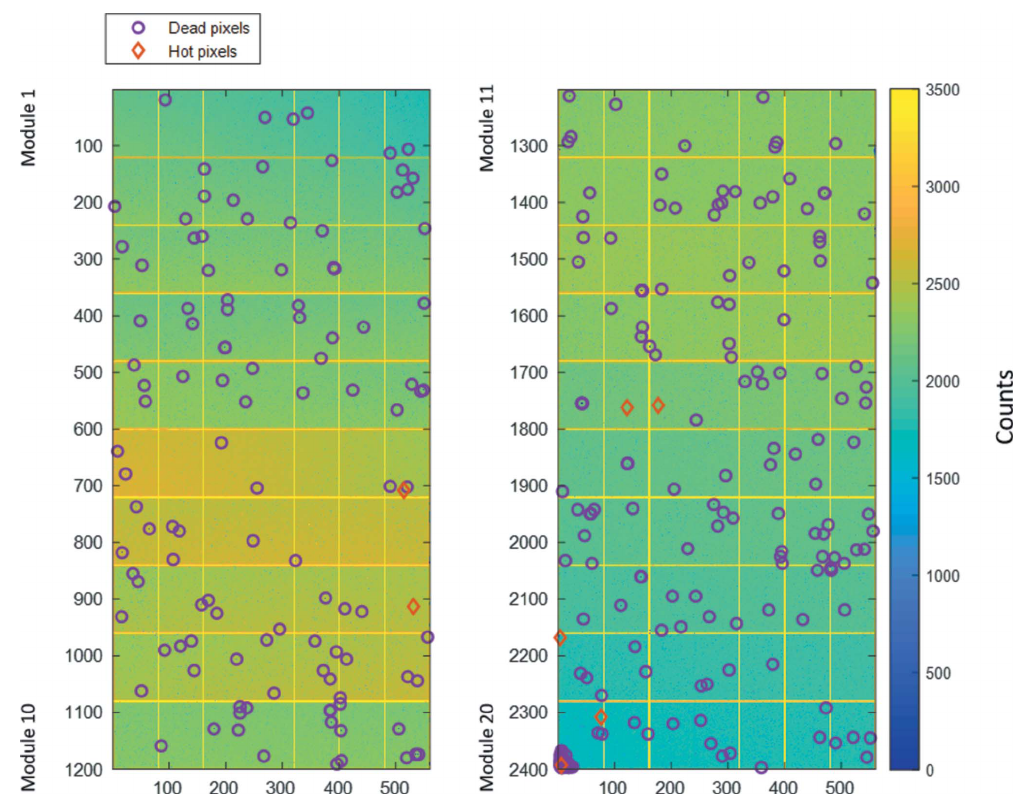
Figure 8 CirPAD image obtained from the scattering of a glass sample, with an energy of 18 keVand for an integration time of 60 s. The left column shows the first 10 modules and the right column shows the other 10 modules. The mean value of the signal per pixel is around 2000 counts. The bright vertical bars correspond to the ‘double’ pixel in the chip edge. The intense horizontal lines originate from the pixels close to the guard ring (Fig. 2). The edge of the last module (lower left corner) was damaged during installation. Note that the arrangement of the modules in the figure does not represent the physical detector Table 3 Total number of CirPAD defects and the less good calibrated pixels counted for SLOW and FAST calibration.